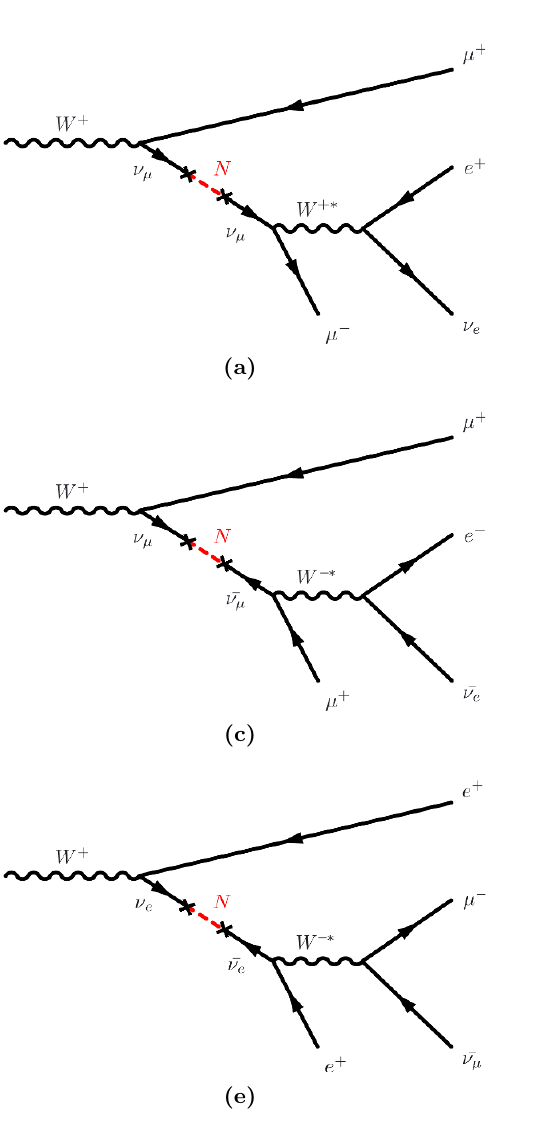
Figure 1. Feynman diagrams for N production and decay in the channels which this search is sensitive to: (a) (cid:22) mixing, (cid:22)e decay, LNC (probed by displaced signature); (b) (cid:22) mixing, (cid:22)(cid:22) decay, LNC (probed by displaced signature); (c) (cid:22) mixing, (cid:22)e decay, LNV (probed by prompt and displaced signatures); (d) (cid:22) mixing, (cid:22)(cid:22) decay, LNV (probed by displaced signature); (e) e mixing, e(cid:22) decay, LNV (probed by prompt signature). Analogous processes involving the decay of the charge-conjugate W (cid:0) boson are also included in the search, but omitted in this (cid:12)gure.